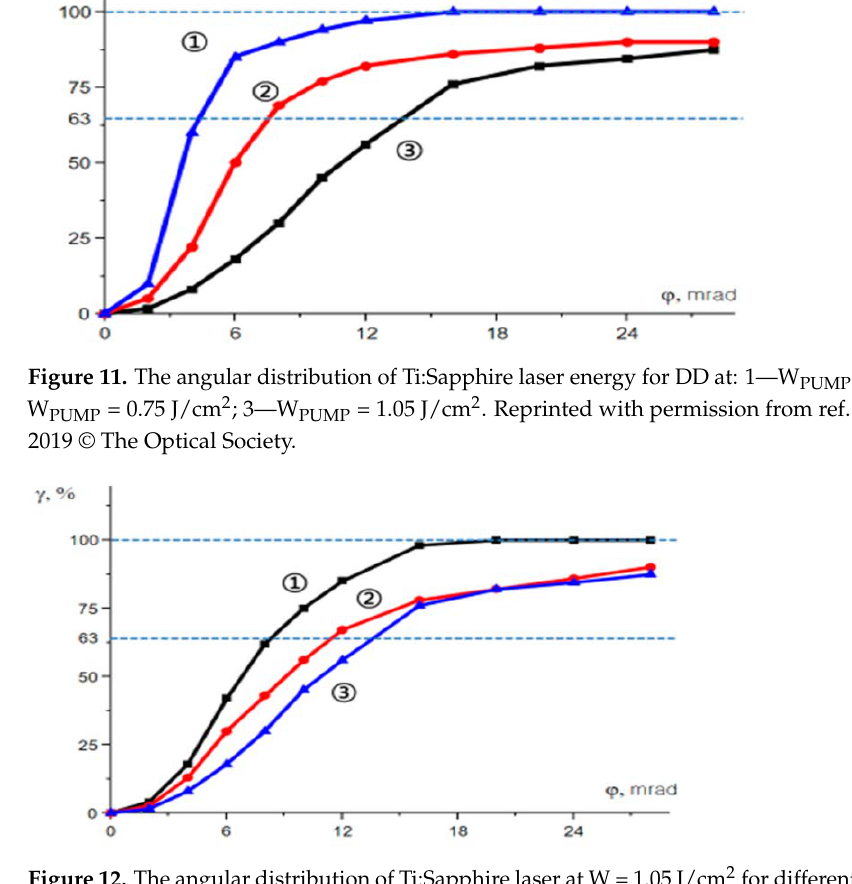
Figure 12. The angular distribution of Ti:Sapphire laser at W = 1.05 J/cm 2 for different pump patterns: 1—single-mode, 2—MLA, 3—DD. Reprinted with permission from ref. [18]. Copyright 2019 © The Optical Society.